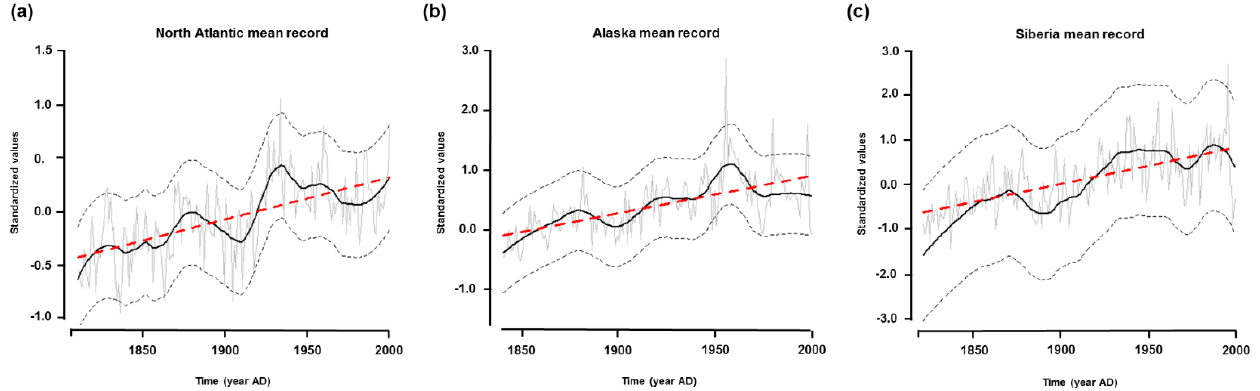
Figure 8. Regional mean records of the last 2 centuries showing the recent warming period. Red dashed lines correspond to a linear trend obtained from a Mann–Kendall test and the black curve corresponds to ∼ 50-year loess filtering. Dashed lines correspond to the 95% confidence level